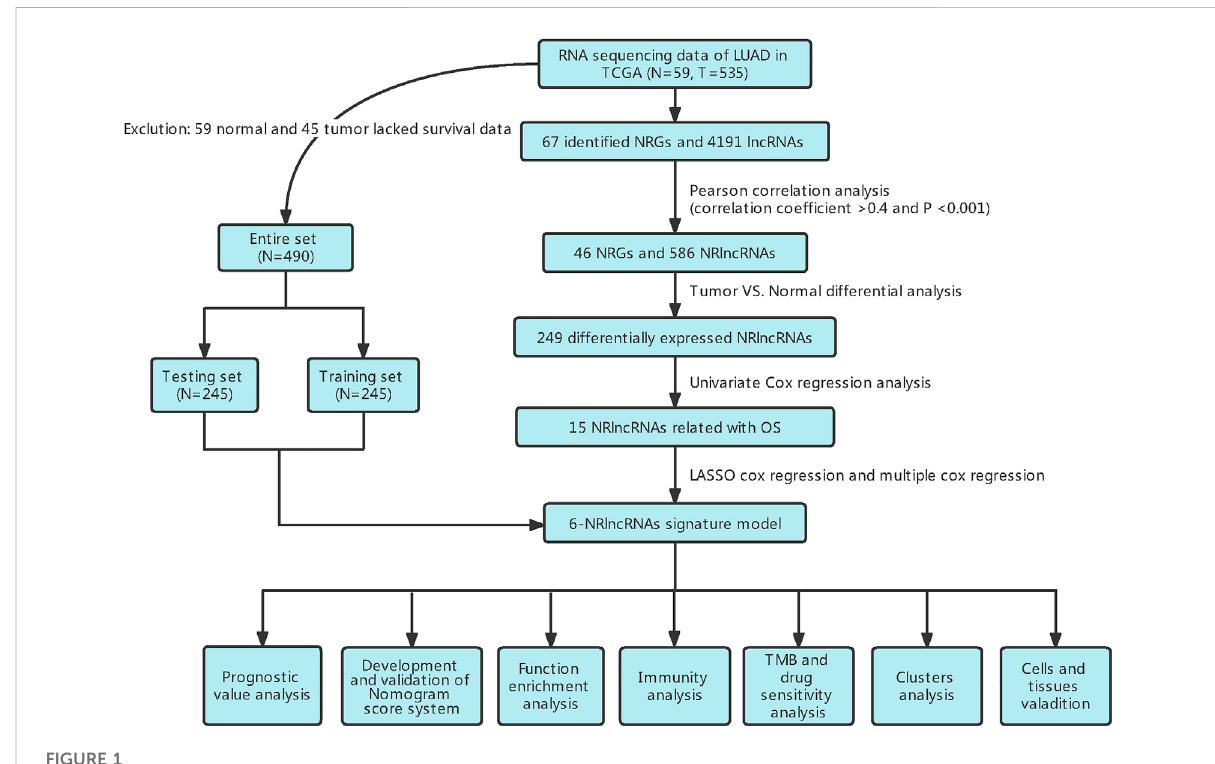
FIGURE 1 Flow diagram of the study